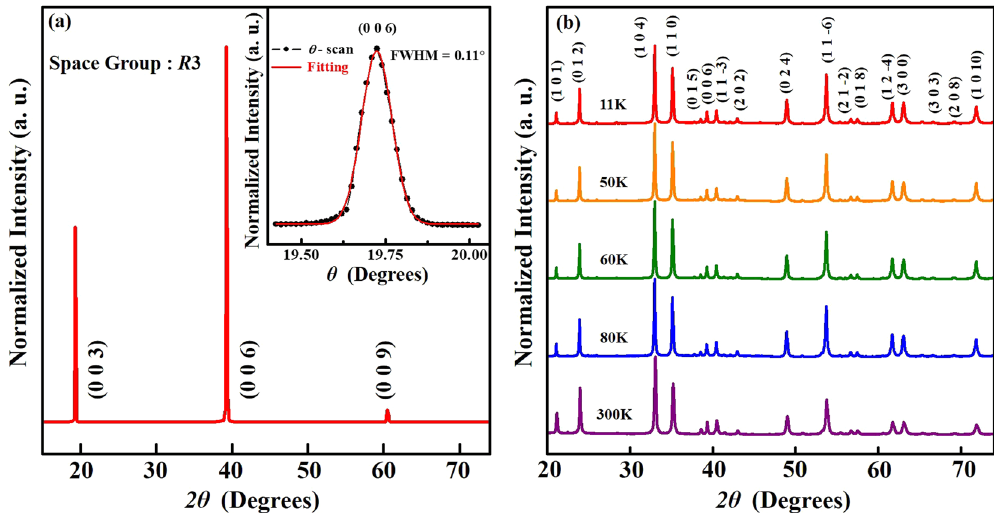
Figure 2. ( a ) 2 θ single-crystal XRD plot on the (003) plane of NTO. The inset shows the θ scan that corresponds to the (006) Bragg peak, which clearly reveals the single crystalline phase of NTO with a single Gaussian peak and a narrow FWHM feature. ( b ) Temperature-dependent powder XRD plot, measured after finely crushing a few NTO crystals. Details of all the peak positions and corresponding ( hkl ) values can be found in Table 1 of the Supplementary